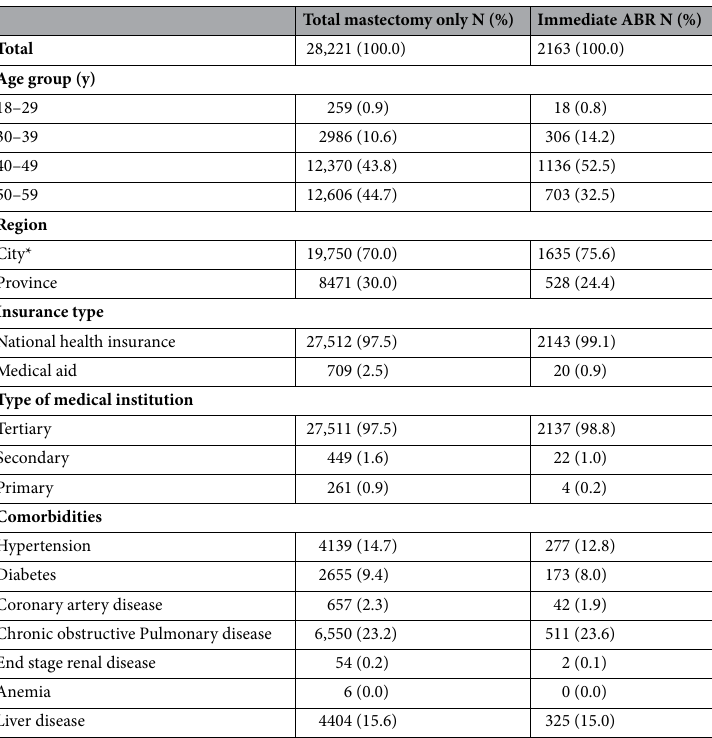
Table 1. Baseline characteristics of the study population. *Seoul, Busan, Incheon, Daegu, Ulsan, Gwangju, and Daejeon. ABR autologous breast reconstruction.